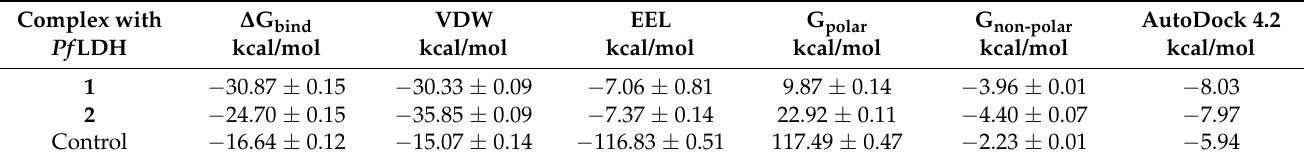
Table 3. The binding free energies (MM-PBSA) for complexes from MD simulation trajectories (90–100 ns). The molecular docking scores from AutoDock 4.2 for the complexes are compared in the